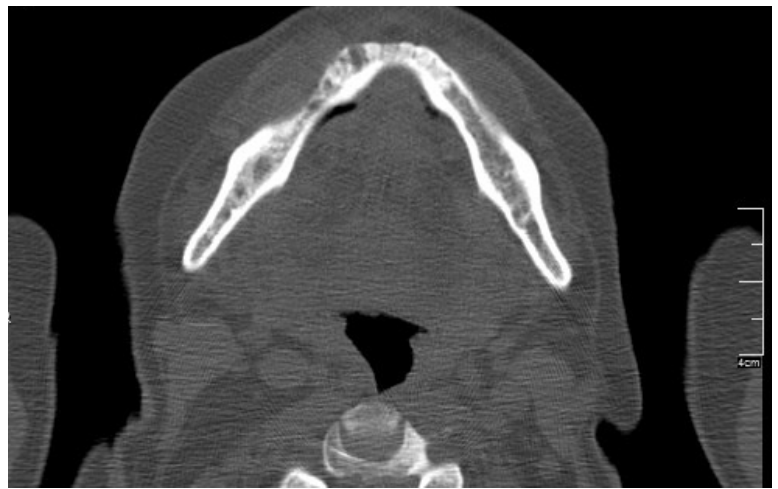
Figure 1. Computed tomography showing mandibular medication-related osteonecrosis of the jaw.